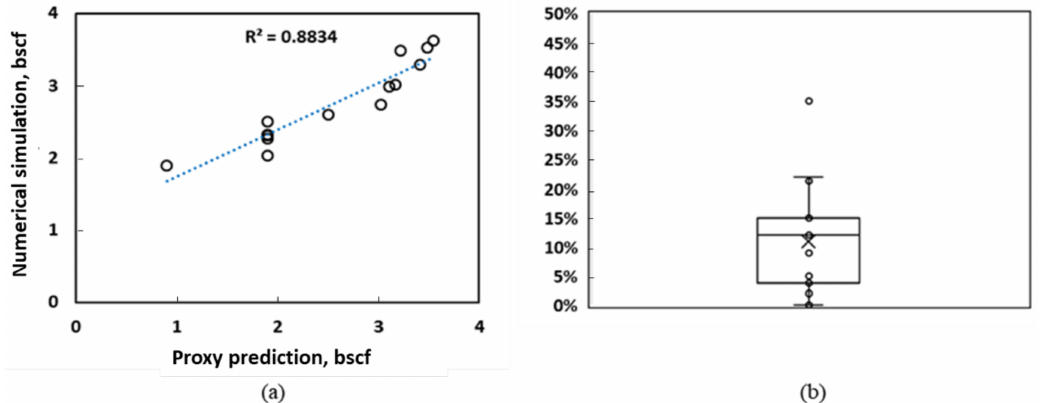
Figure 13. Blind test results using the Stacked learner proxy for CO 2 storage ( a ) and box and whisker plot ( b ) of the relative errors for the blind test